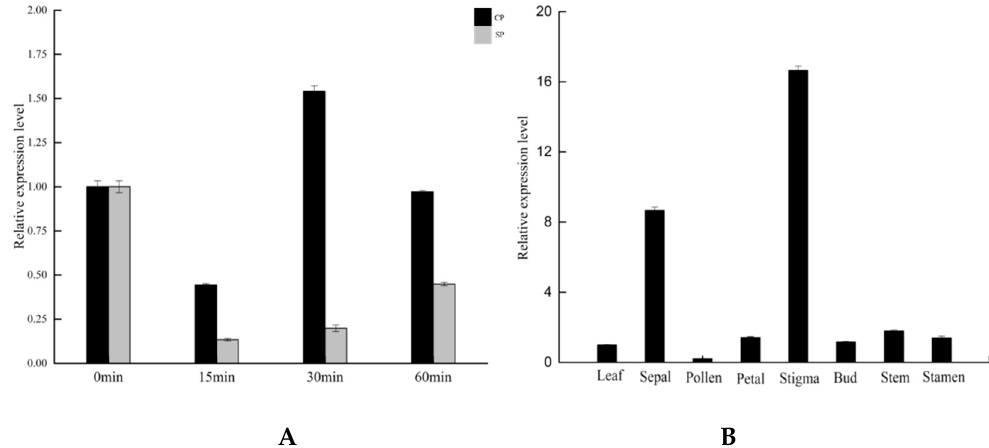
Figure 8. ( A ) BoGAPC expression analysis after pollination. The pollination period is 0 min, 15 min, 30 min and 60 min. SP: self-pollination; CP: cross-pollination. ( B ) Tissue expression analysis, B. oleracea tissue includes leaves, sepal, pollen, petals, stigma, bud, stem and stamen.